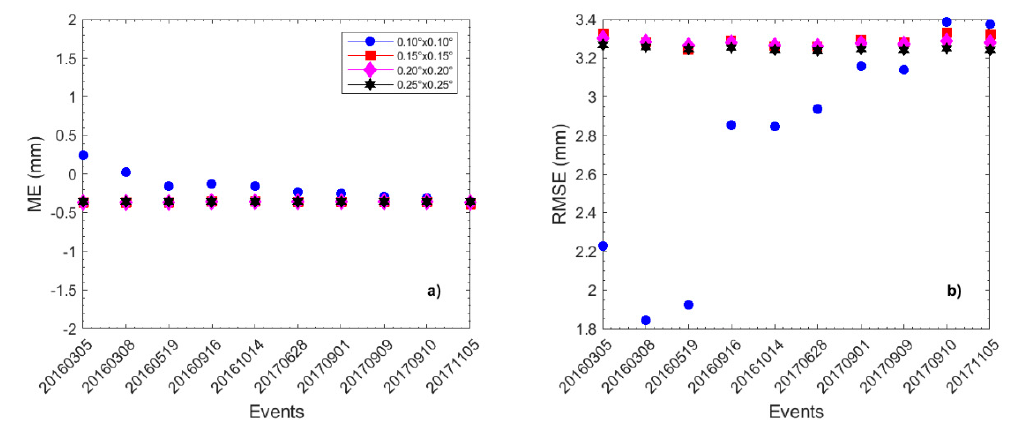
Figure 11. ( a ) ME and ( b ) RMSE scores calculated by comparing the RAINBOW outputs with the GRISO data (taken as reference) on different regular grids for 10 case studies. A minimum cumulated rain threshold is set at 0.25 mm.